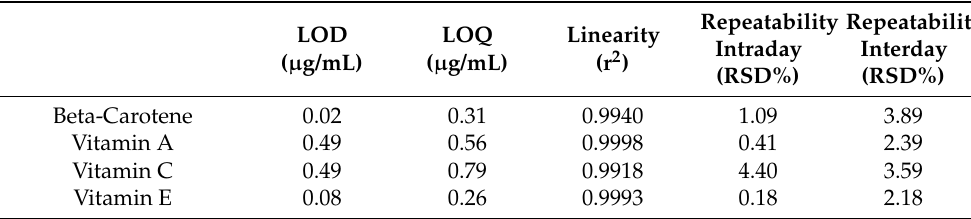
Table A2. Data from the instrumental validation of the chromatographic method developed for the quantification of vitamins and Beta-Carotene in habanero pepper